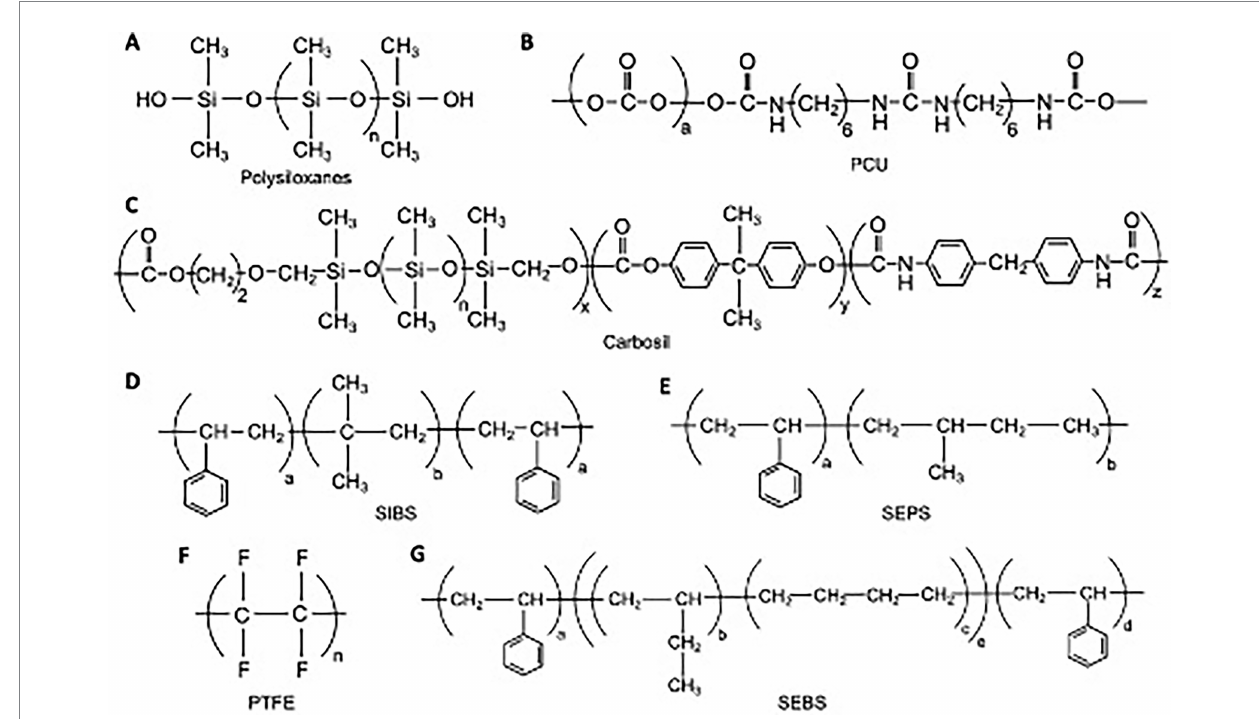
FIGURE 2 Chemical structures for various polymer compounds used in PHV construction. (A) Polysiloxanes; (B) Polycarbonate urethane; (C) Carbosil TSiPCU; (D) Poly(styrene-b-isobutylene-b-styrene); (E) Poly(styrene-b-isobutylene-b-styrene); (F) Polytetrafluoroethyelene; (G) poly(styrene-b-ethylene/